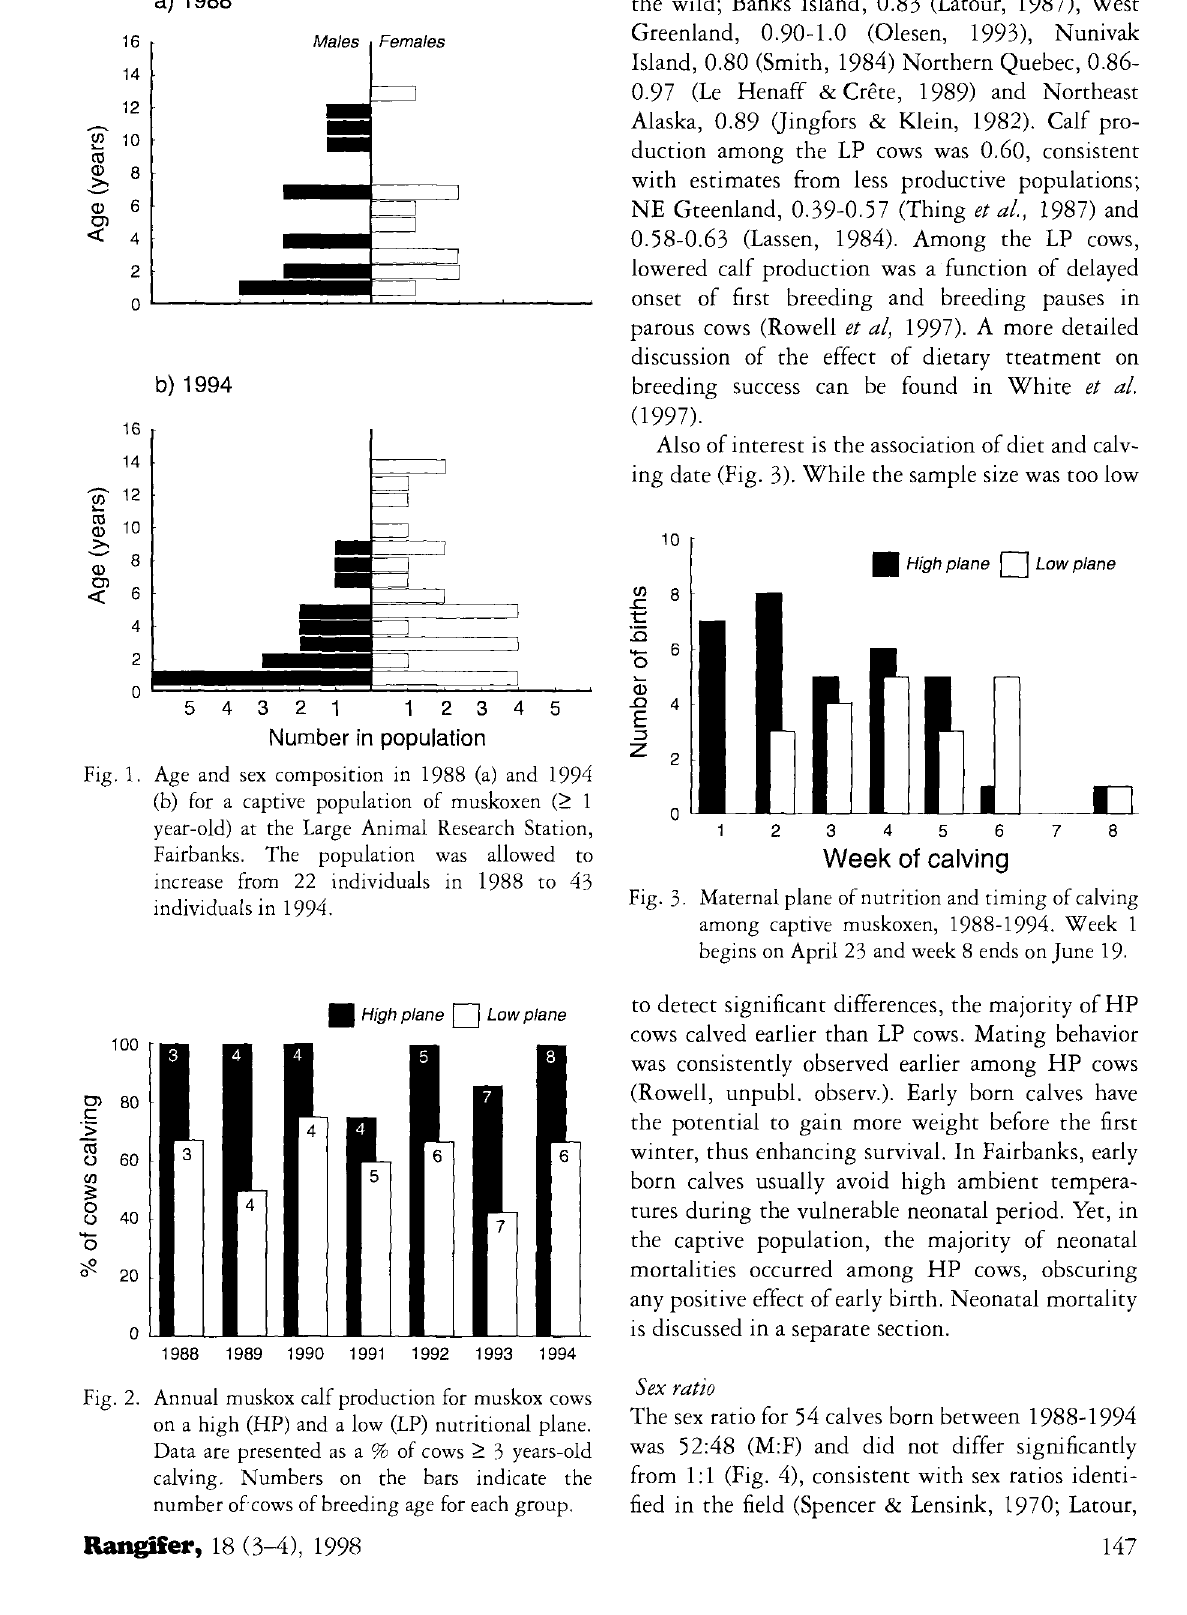
Fig. 2. Annual muskox calf production for muskox cows on a high (HP) and a low (LP) nutritional plane. Data are presented as a % of cows > 3 years-old calving. Numbers on the bars indicate the number of cows of breeding age for each group.